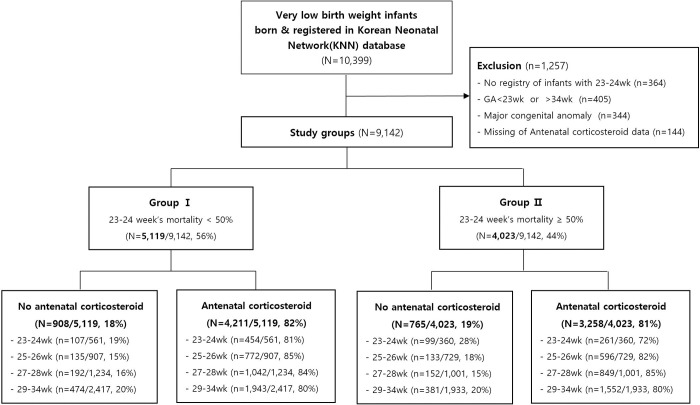
The wide variability of the mortality rate among infant born at 23–24 weeks gestation from the Korean Neonatal Network included in this study.